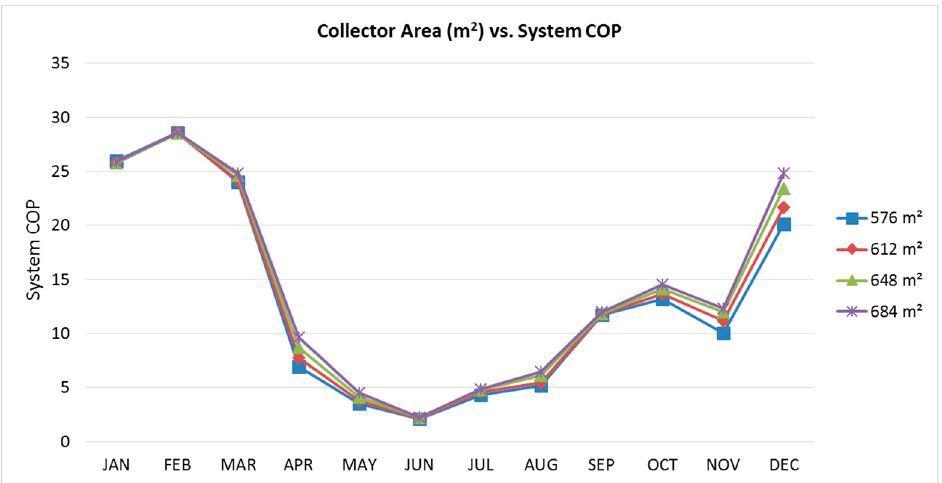
Figure 10. The impact of the solar collector area on system COP.